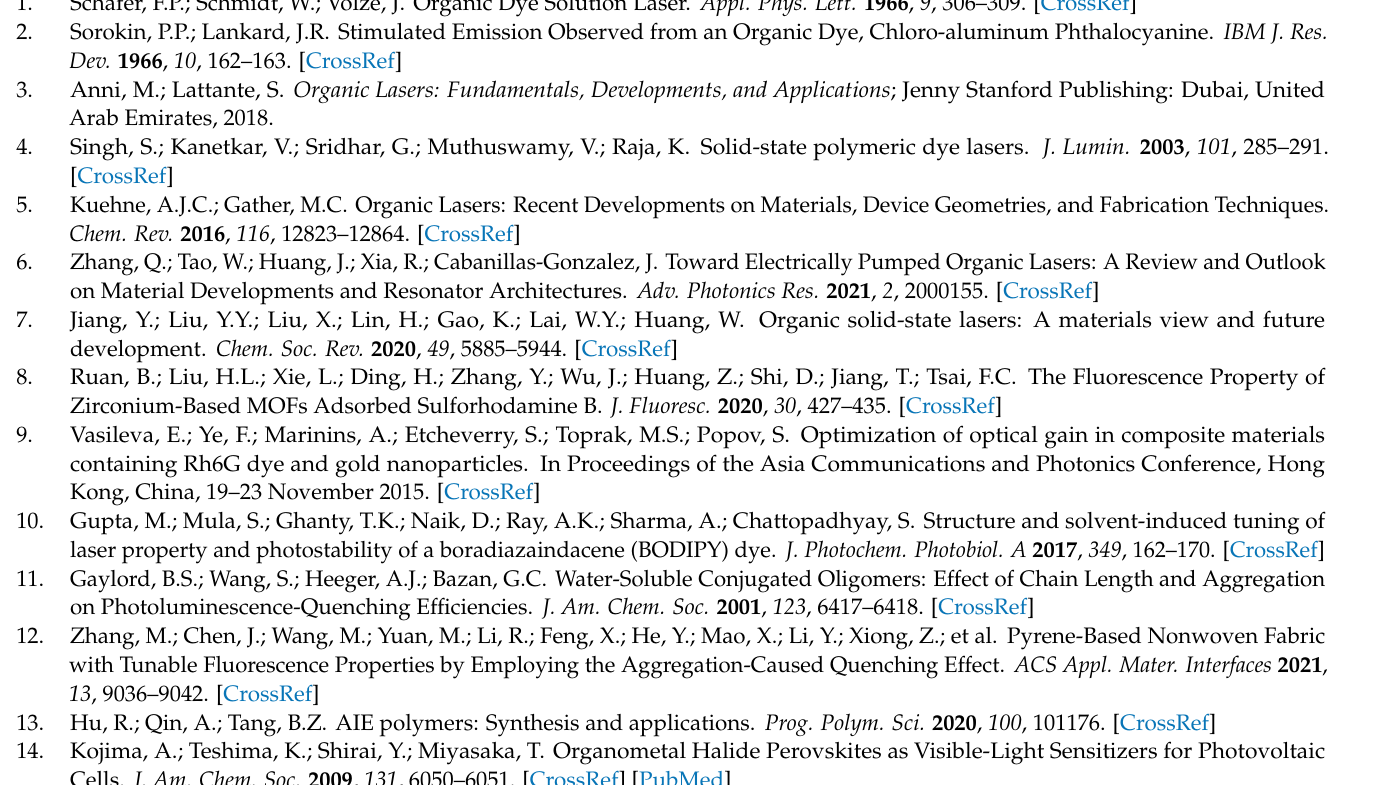
Figure S4: Excitation density dependence of the PL spectra, output intensity, and FWHM of the PO-PMMA blend; Figure S5: Total integrated intensity plots for quasi-2D perovskite thin film, PO, and rosamine4